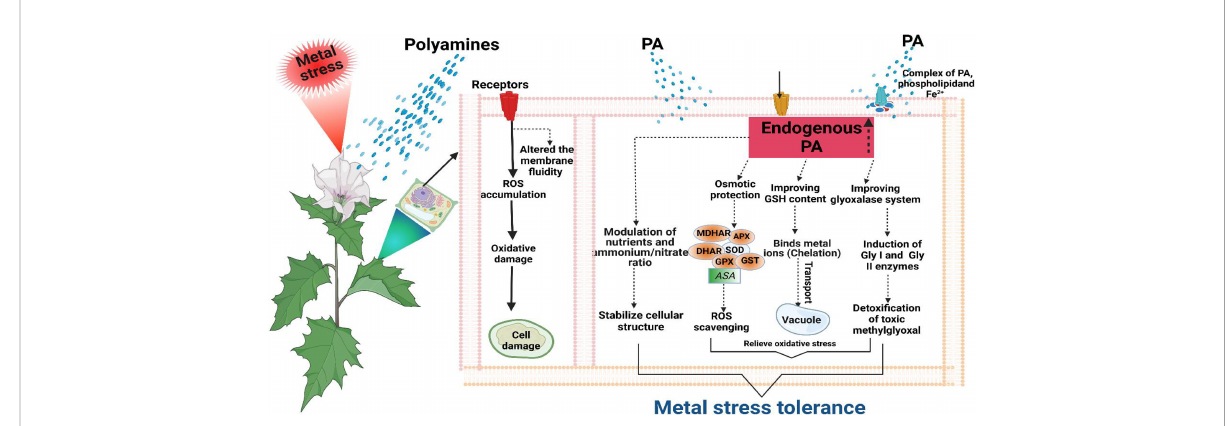
FIGURE 6 Metal stress tolerance with the exogenous application of PAs. Protecting the membrane structure by forming complexes with phospholipid and Fe 2+ . PAs improve the glyoxalase system through inducing glyoxalase I (Gly I) and glyoxalase II (Gly II) enzymes that detoxify the toxic methylglyoxal. Enhances the glutathione (GSH) level, which involves metal chelation and transportation into vacuole for detoxi fi cation. Improves the activity of enzymes (SOD, superoxide dismutase; CAT, catalase; APX, ascorbate peroxidase; MDHAR, monodehydroascorbate reductase; DHAR, dehydroascorbate reductase; GR, glutathione reductase; GST, glutathione S-transferase; GPX, glutathione peroxidase) and nonenzymatic antioxidants (ascorbate, AsA). Hence, reduced oxidative stress directly and indirectly. Maintaining the cellular structure through modulation of nutrition and ammonium/nitrate